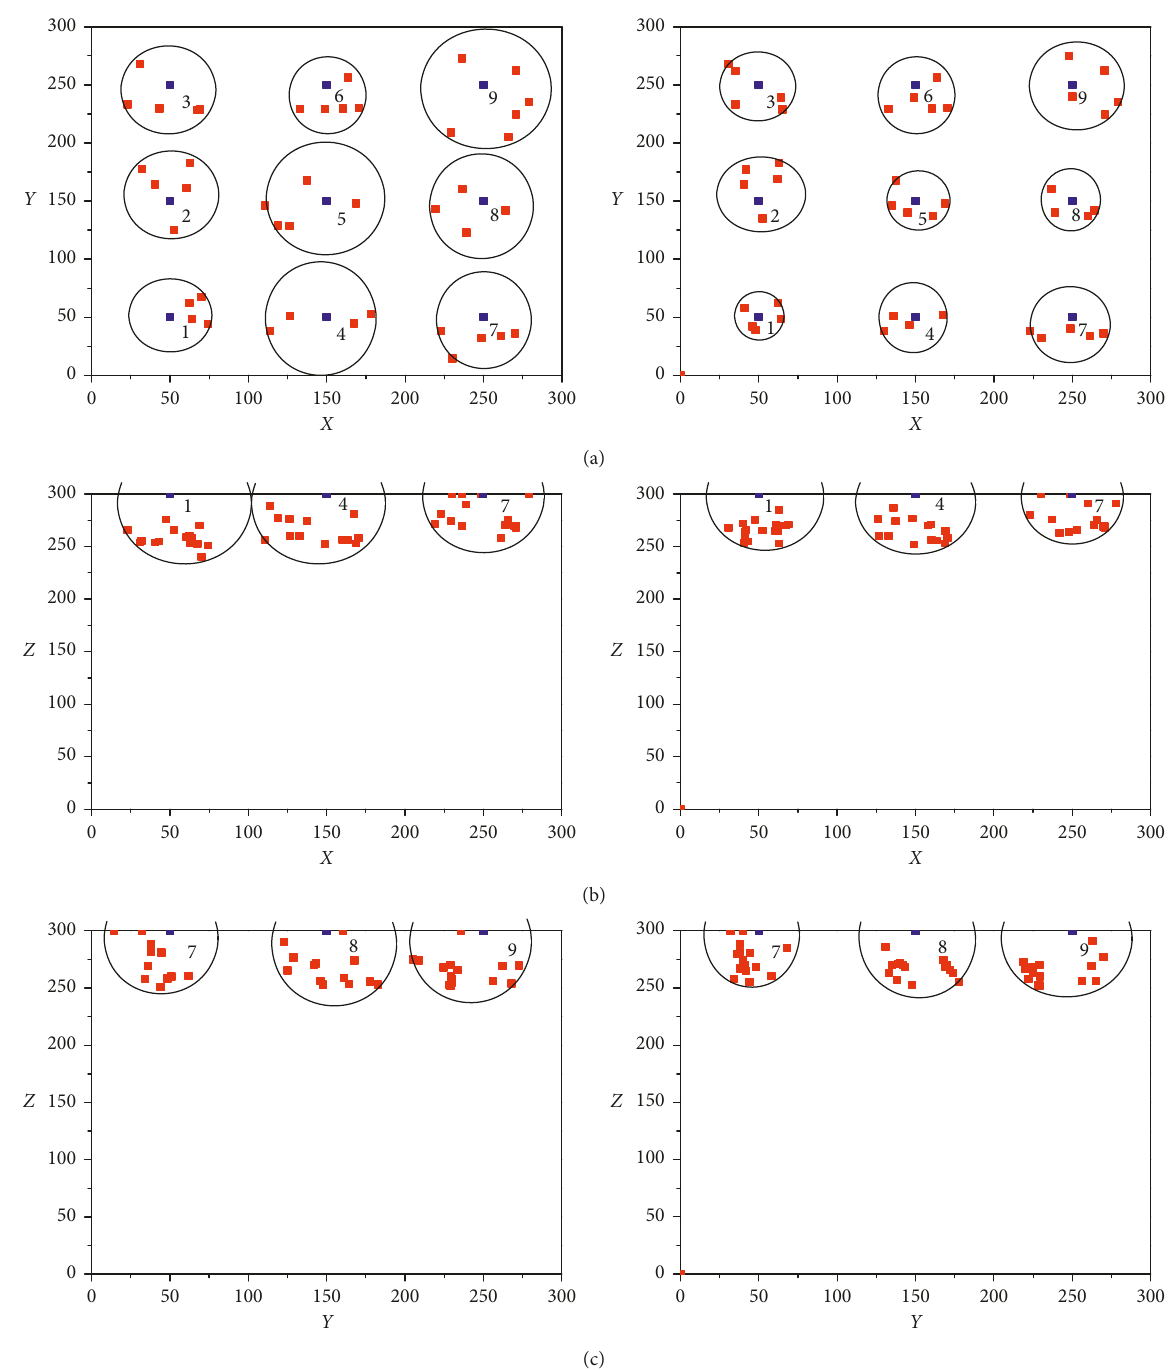
Figure 10: Different plane projections of localization results for sensor 4#. Blue points are break points, red points are locating points, and semicircles are deviation area. The localization results before (left) and after (right) the wave speed modification on (a) x - y plane projections, (b) y - z plane projections, and (c) x - z plane